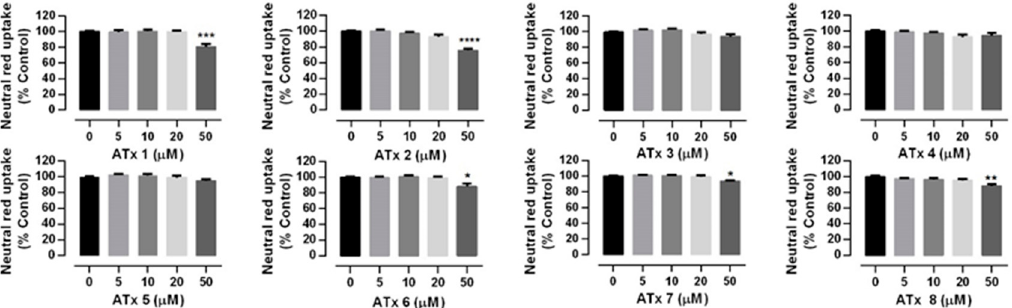
Figure 3. Chiral thioxanthones ATxs 1 – 8 (0–50 µ M) cytotoxicity in Caco-2 cells evaluated by the Neutral Red uptake assay, 24 h after exposure. Results are presented as mean ± standard error mean (SEM) from at least 5 independent experiments (performed in triplicate). Statistical comparisons were estimated using the nonparametric method of Kruskal–Wallis (one-way ANOVA on ranks), followed by the Dunn’s multiple comparisons post hoc test (* p < 0.05; ** p < 0.01; *** p < 0.001; **** p < 0.0001 vs. control (0 μ M)).